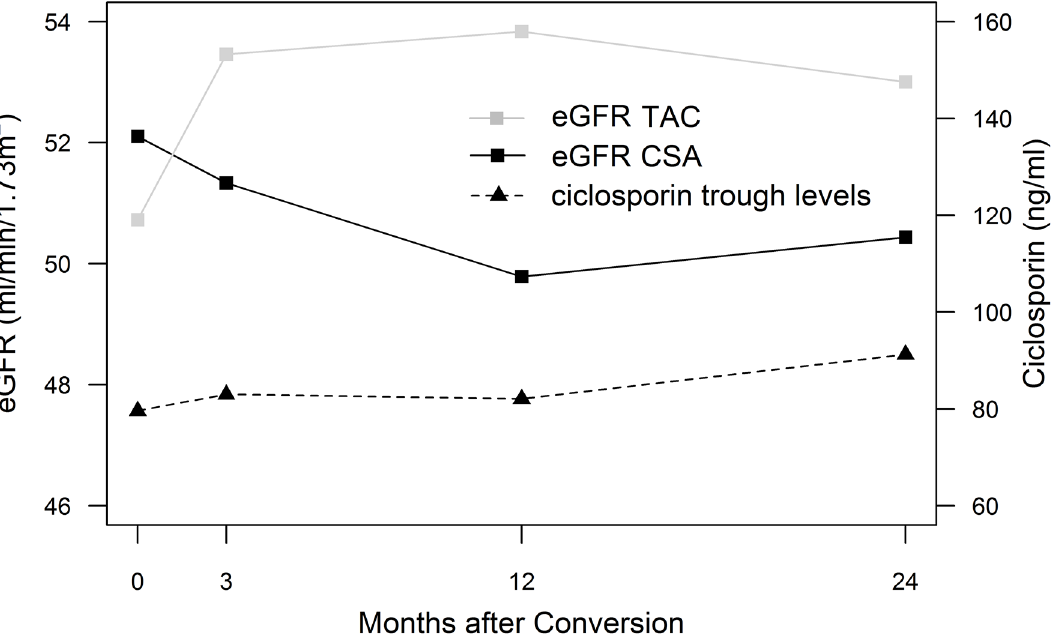
Fig 3. CSA and TAC group eGFR courses compared. Mean eGFR CKD-EPI for the CSA (solid black line) and TAC study group (solid grey line) at baseline, 3, 12 and 24 months after conversion. Ciclosporin trough levels (dashed line) at the same timepoints.